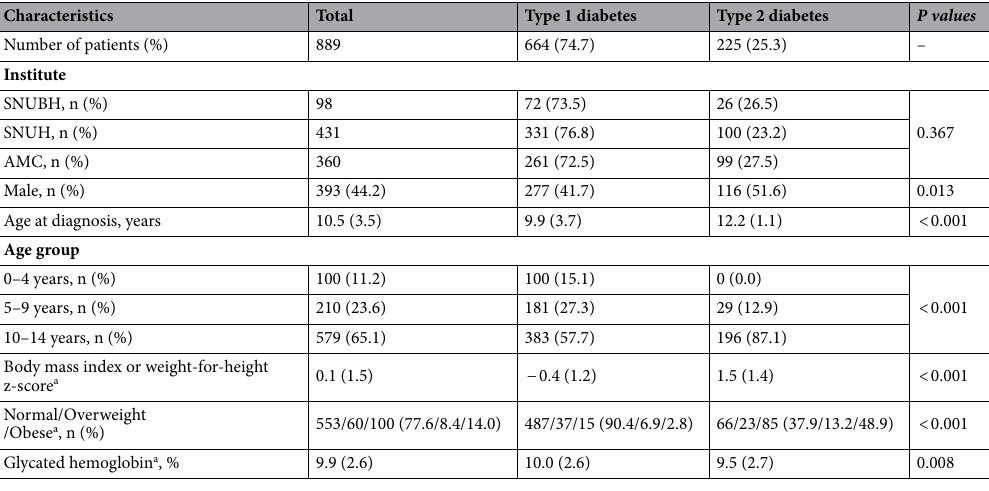
Table 1. Baseline characteristics of the study participants. Data are presented as means (standard deviation) for continuous variables and numbers (%) for categorical variables. p -values are for Student’s t -test (continuous variables) or the chi-squared test (categorical variables). a Body mass index z-scores at baseline were available for 713 patients, and the glycated hemoglobin level at baseline was available for 831